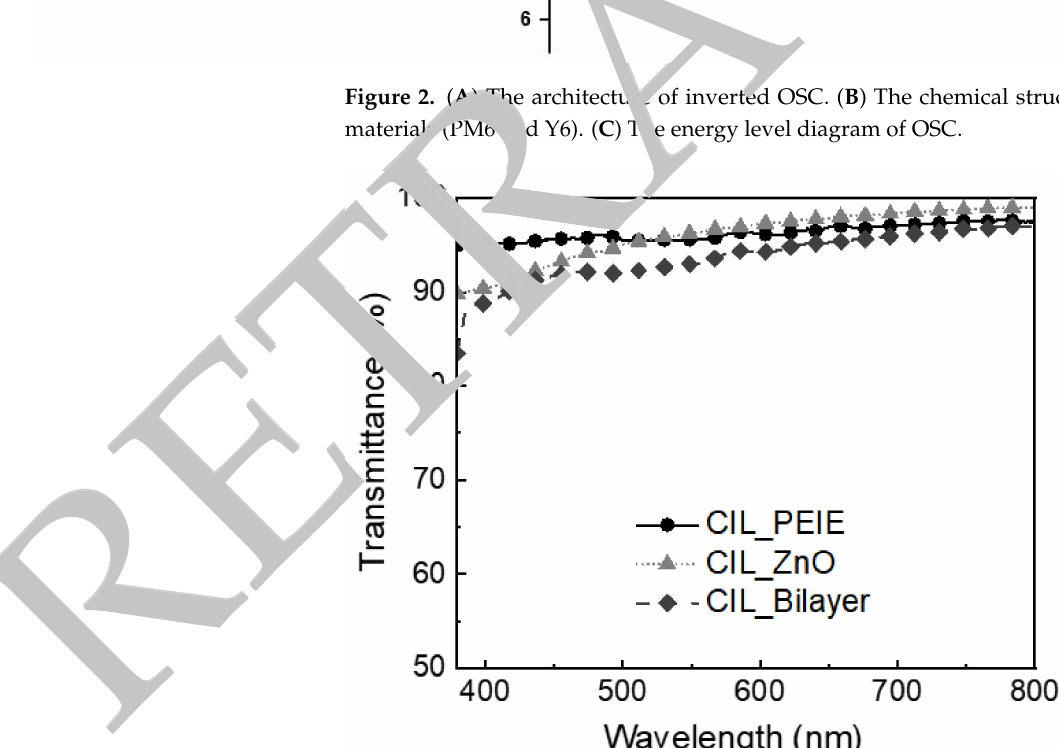
Figure 2. ( A ) The architecture of inverted OSC. ( B ) The chemical structures of photoactive layer materials (PM6 and Y6). ( C ) The energy level diagram of OSC.